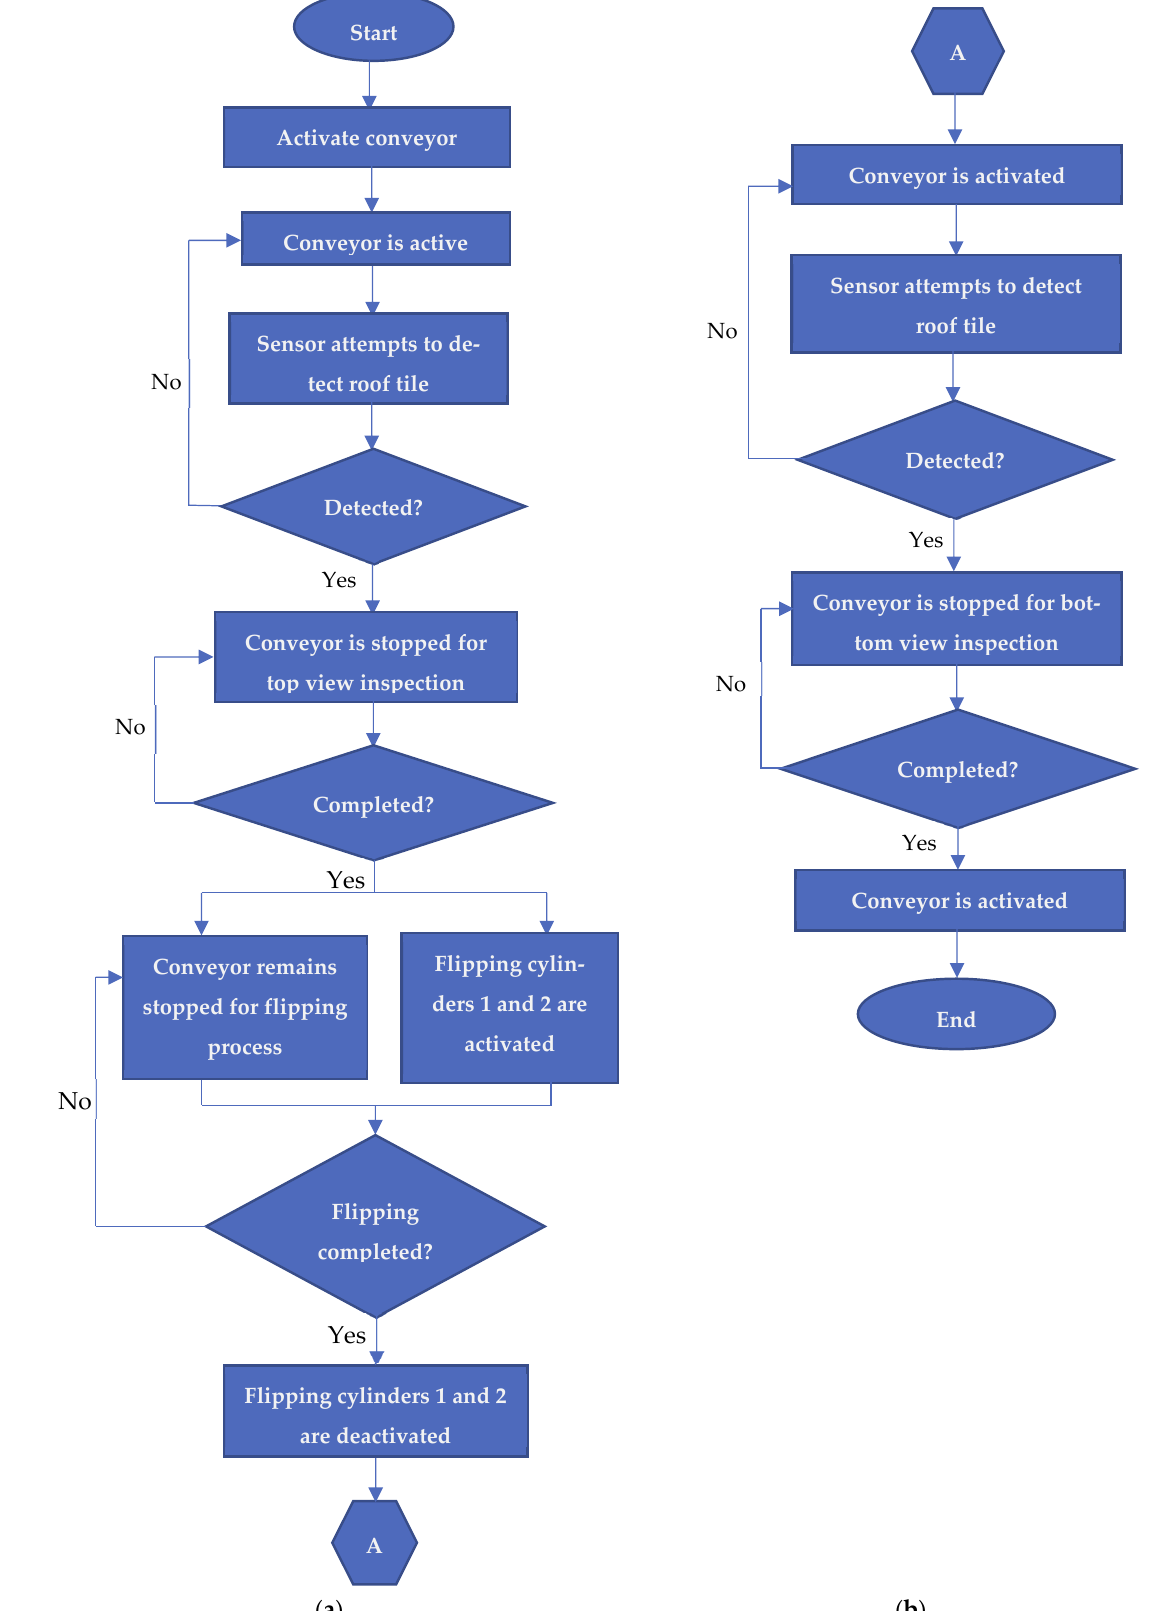
Figure 4. Process flow of roof tile transportation and inspection system. ( a ) Process from start to A; ( b ) Process from A to